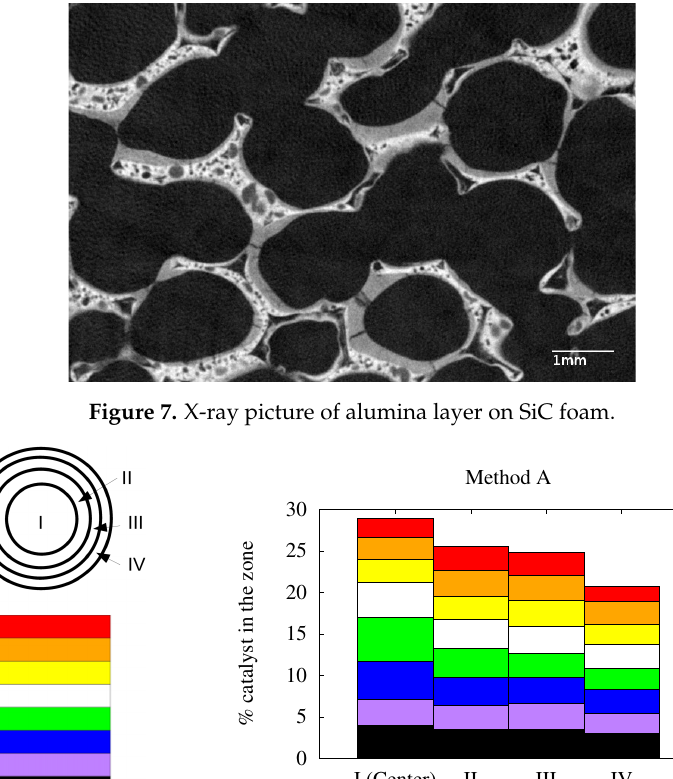
O layer thickness on SiC foam 2 3